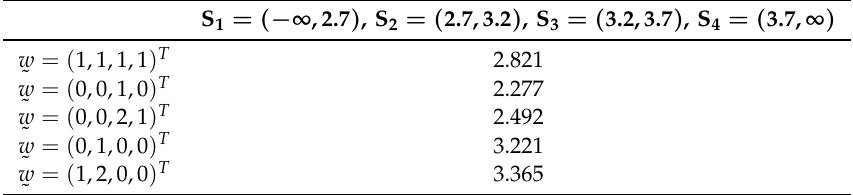
Table 8. CWKL divergence between π 1 and π 3 .